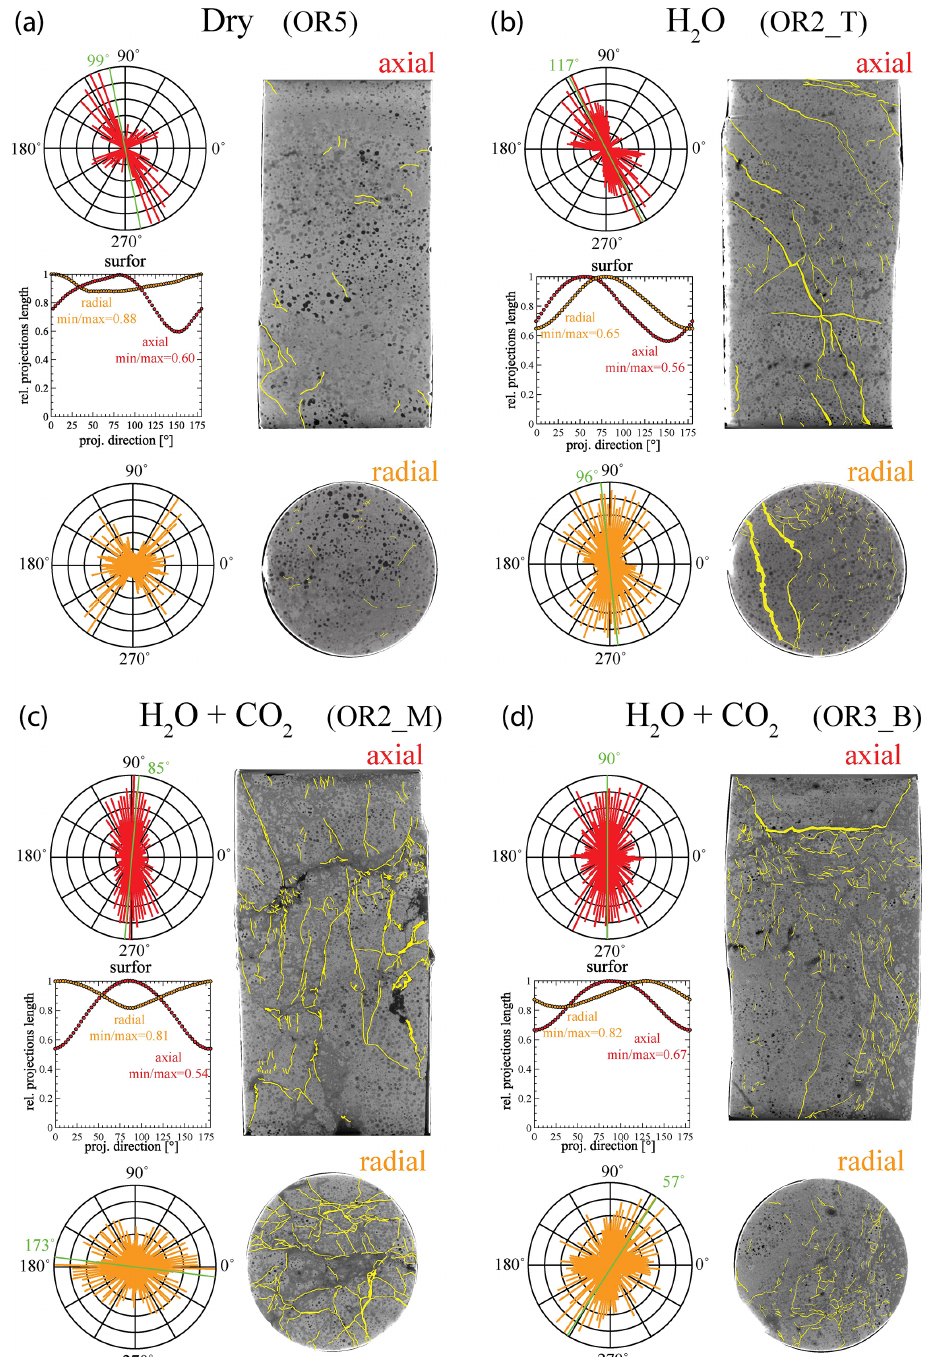
Figure 11. Orientation analysis of cracks in axial and radial directions from X-ray tomographic images of the deformed sample from (a) dry, (b) H 2 O, (c) H 2 O + CO 2 closed and (d) H 2 O + CO 2 open experiments. The aspect ratio (min / max), which is defined by the ratio between the minimum and maximum projection length of the cracks, is 1 when the orientation is random (isotropic) (Heilbronner and Barrett, 2014). Strong crack alignment is inferred in the axial sections with aspect ratio of 0.5–0.7 compared to the radial sections where the aspect ratio is